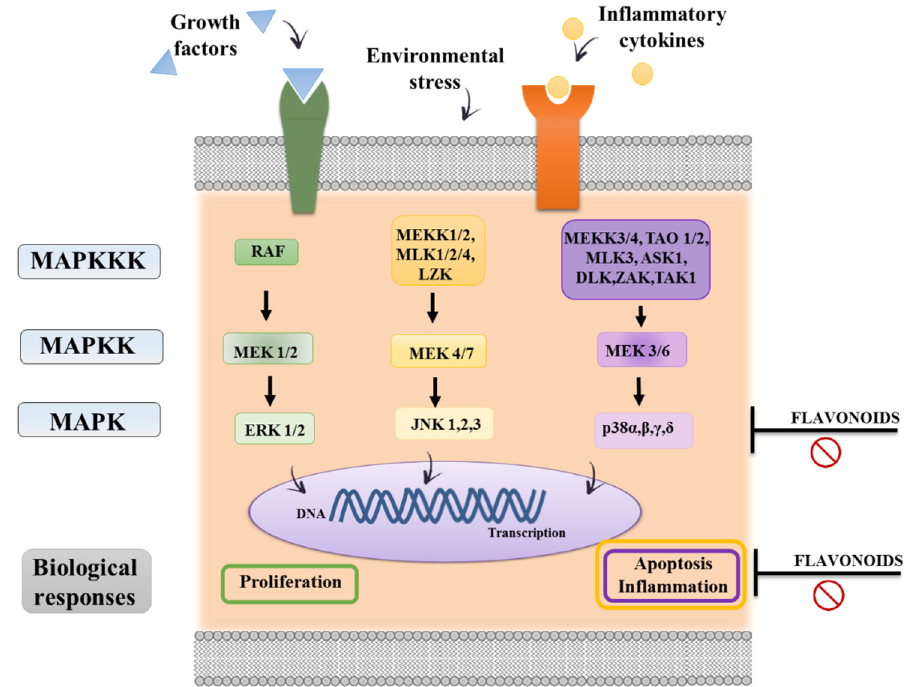
Figure 6. MAP Kinase pathway. The mitogen-activated protein kinase (MAPK) cascades are signal transduction pathways that involve a chain of three kinases activating each other in a series (MAPKKK, MAPKK, and MAPK). The result of phosphorylation of various MAP kinase isoforms is the activation of the three main MAP kinases: ERK (extracellular signal-related kinase), p38 MAPK, and JNK (c-Jun NH2-terminal kinase). Cell division, migration, and survival generally involve ERK signaling. Cellular stress activates the p38 MAPK and JNK pathways. The p38 MAPK pathway mediates transcription and cell motility. JNK signaling regulates apoptosis and inflammation. Flavonoids’ immunomodulatory signal transduction events upstream of the relevant MAPK